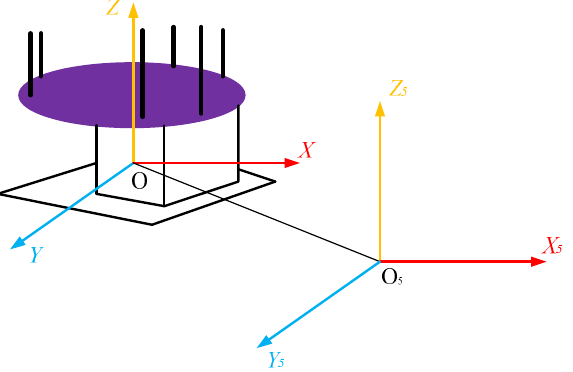
Figure 4. Attitude transformation of the active motion simulator.